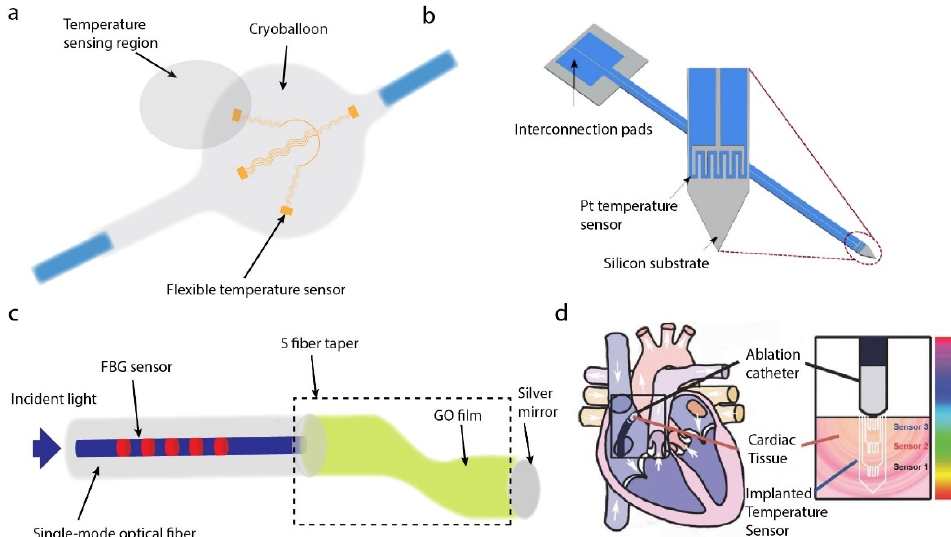
Figure 5. Probes for in vivo temperature sensing. ( a ) Flexible platinum-based temperature-sensing microsensors for cryoablation temperature monitoring [55]. ( b ) Pt-thermo-resistance-based temperature sensor for temperature monitoring to prevent overheating issues in optogenetics [56]. ( c ) Reflective FBG-based probe for temperature sensing [59]. ( d ) Ultrathin temperature sensor for cardiac ablation monitoring. Reprinted with permission from Ref. [60]. Copyright 2015, John Wiley and Sons.